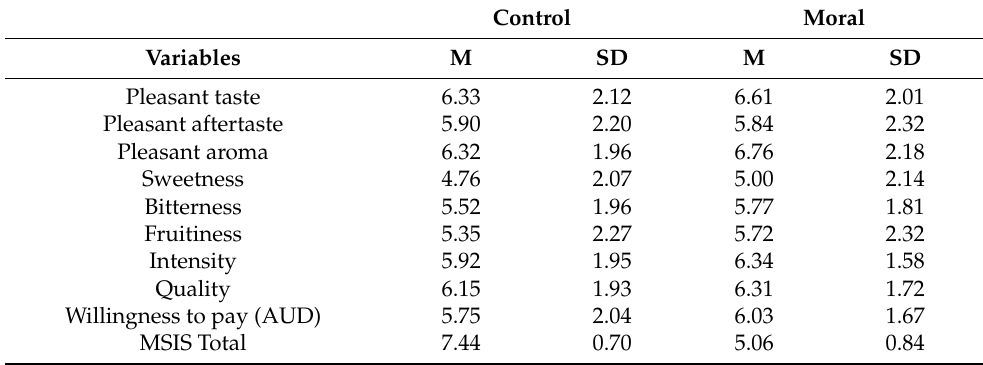
Table 1. Descriptive statistics for beer flavour characteristics for control and moral groups.